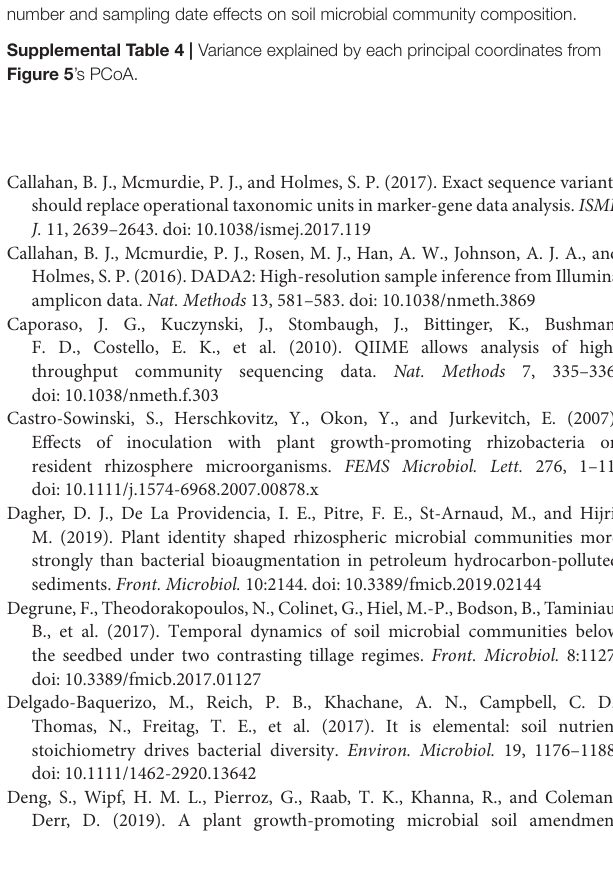
Supplemental Table 2 | Chemical properties of soil for all soil sampling dates.